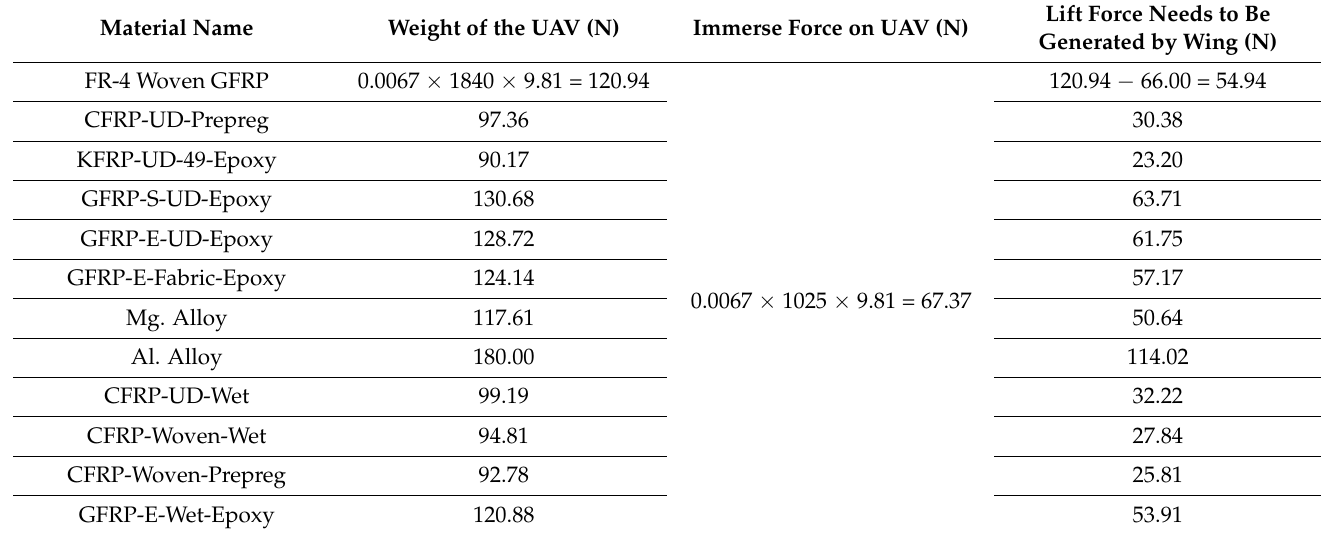
Table 6. Comparative force analyses under the hydrodynamic environments on and over the